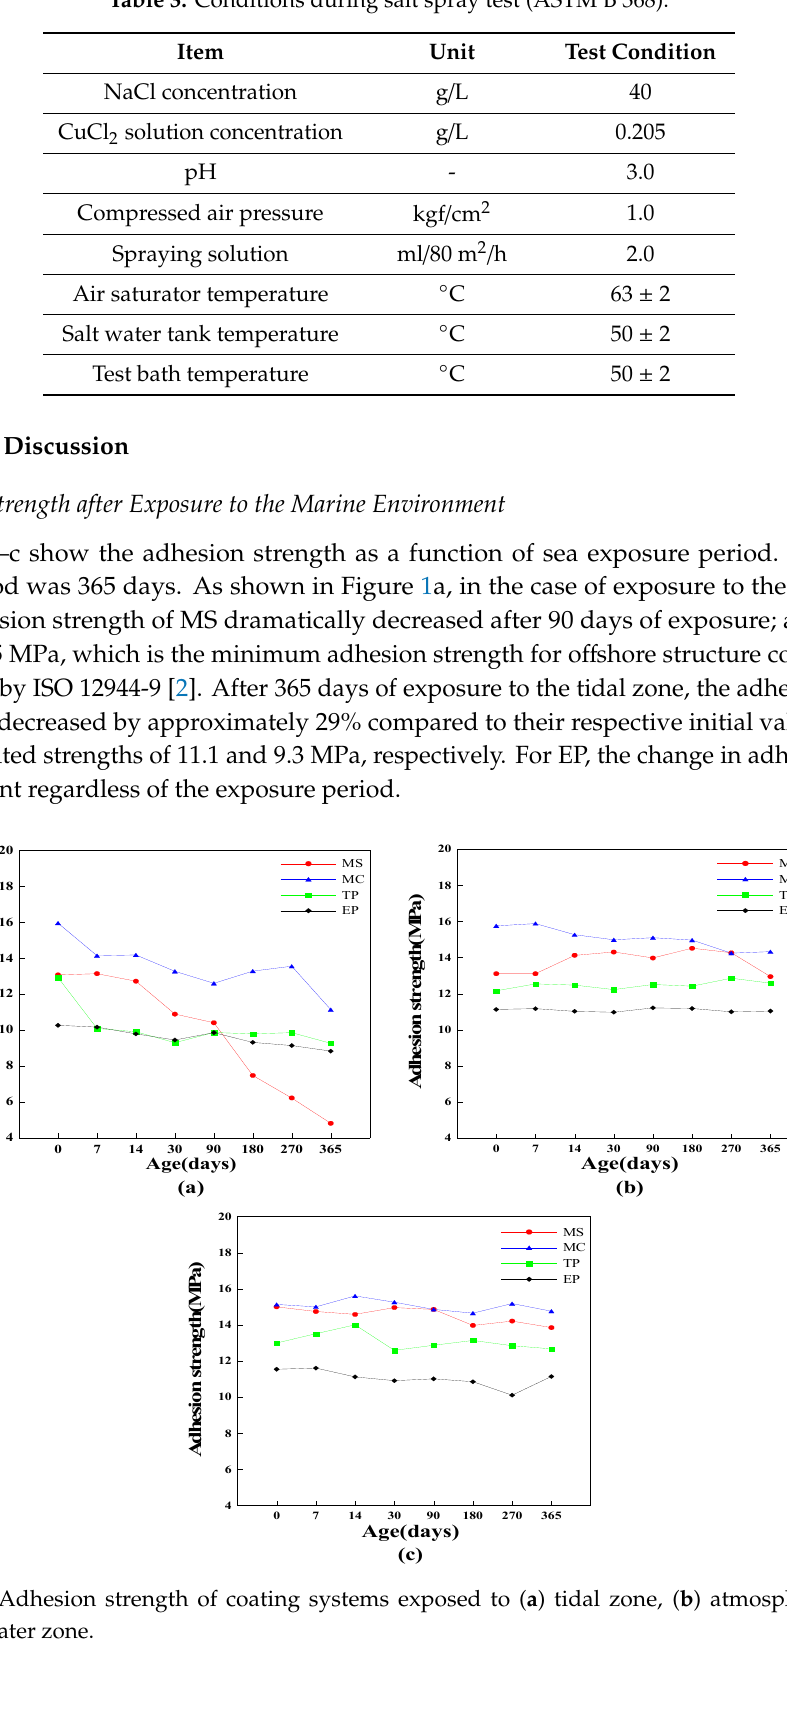
Table 3. Conditions during salt spray test (ASTM B 368).